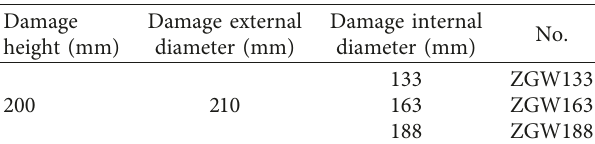
Table 3: Dimensions of the model with circumferential column foot